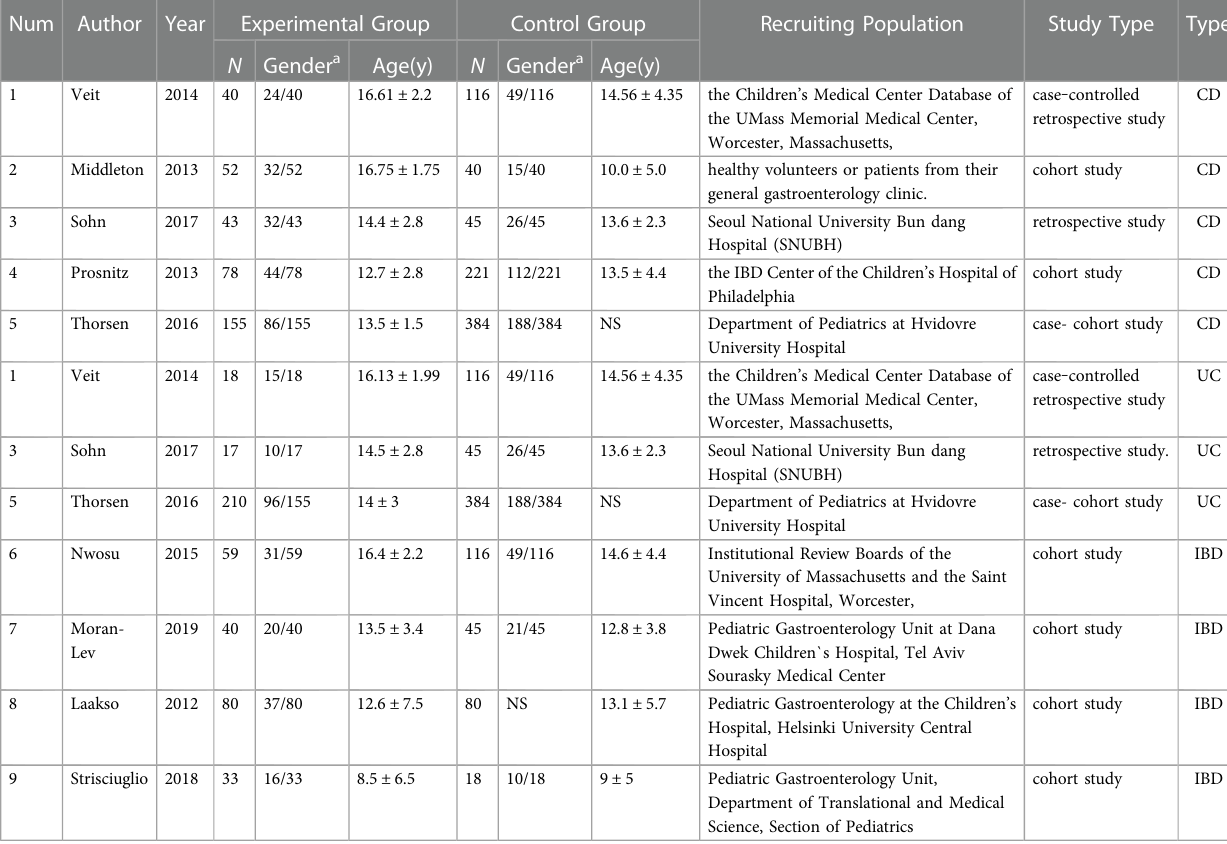
a Gender: Proportion of males in the total population.